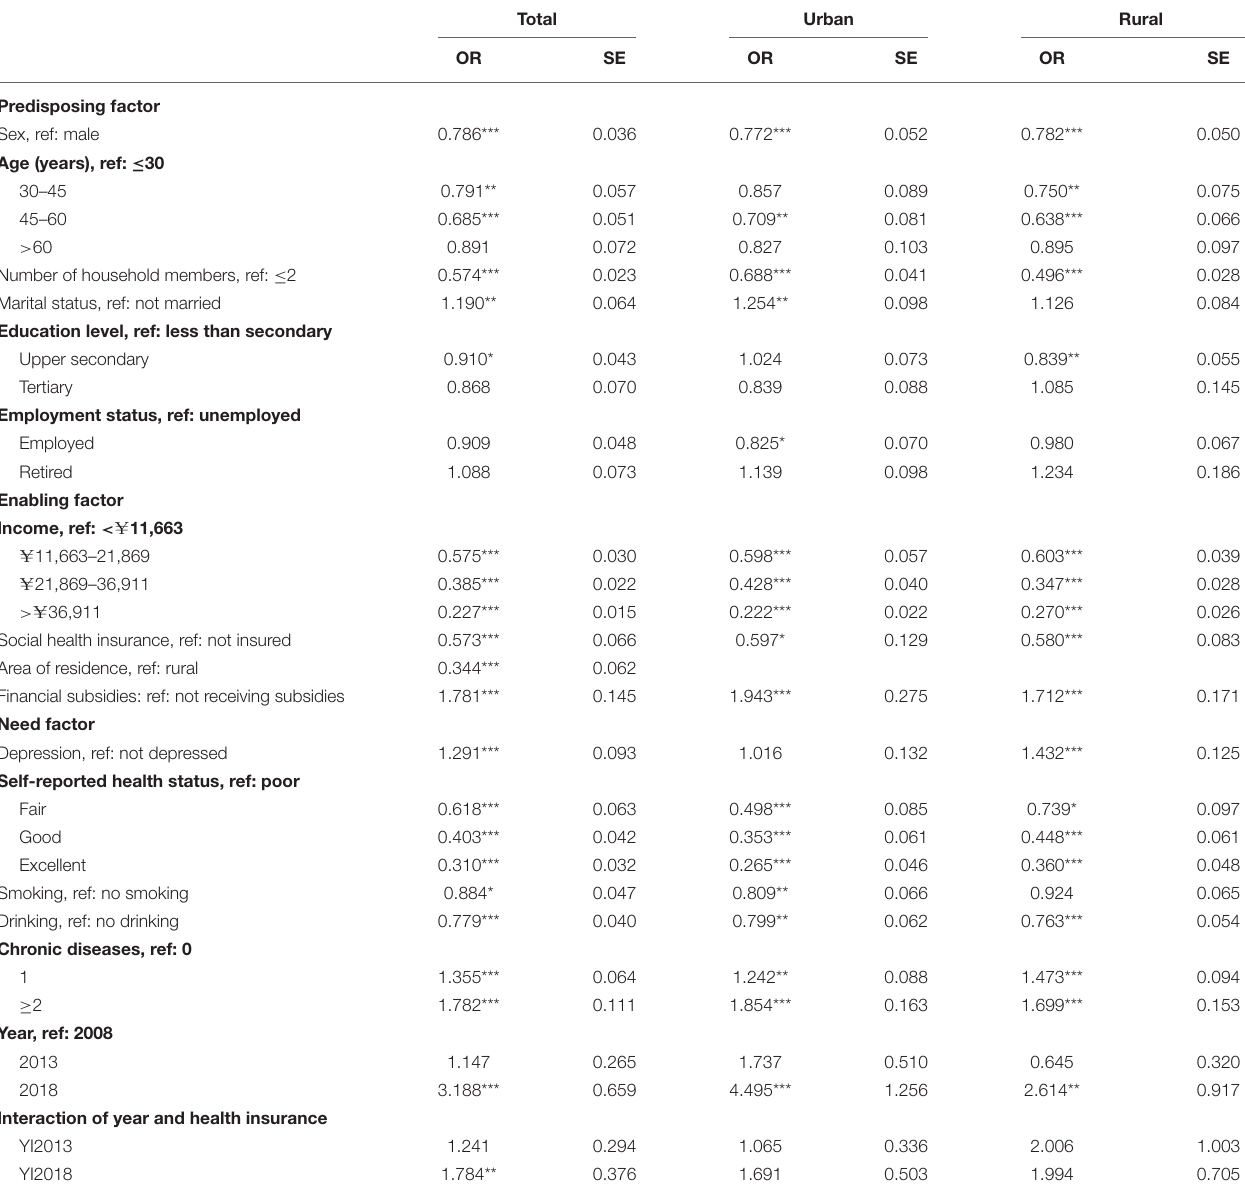
TABLE 5 | Logistic regression analysis of the likelihood of household catastrophic health expenditure of urban and rural